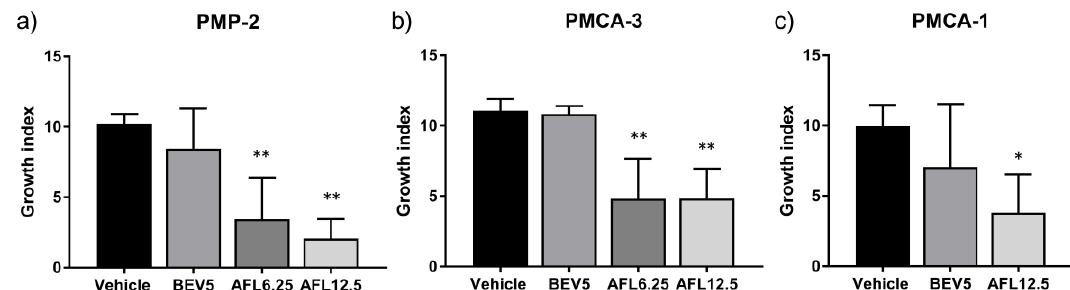
Figure 3. Responses to anti-angiogenic drugs bevacizumab (BEV, mg/kg) and aflibercept (AFL, mg/kg) treatment in patient derived xenograft models of pseudomyxoma peritonei, ( a ) PMP-2, ( b ) PMCA-3 and ( c ) PMCA-1. Error bars indicate standard deviation. *, p < 0.01; **, p < 0.001 for comparisons with vehicle treatment.